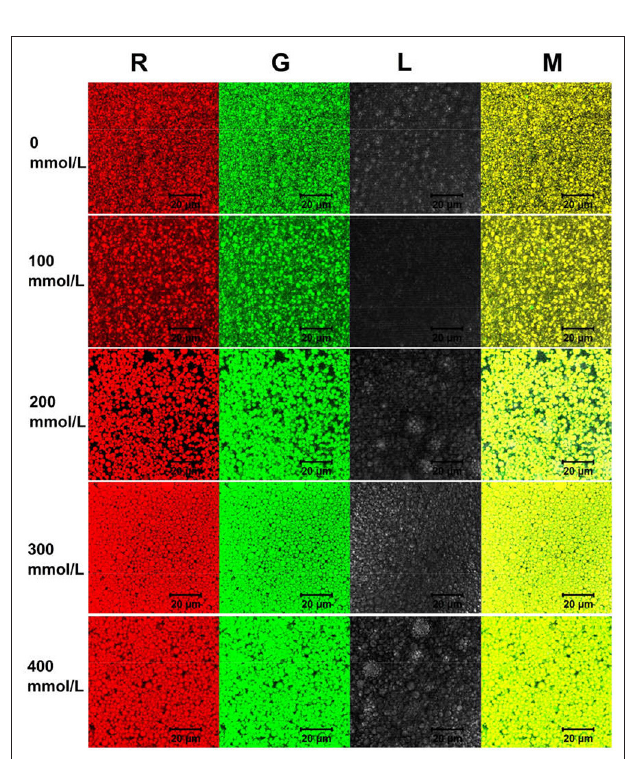
FIGURE 7 | Confocal laser scanning microscopy images of Pickering emulsions by tea water-insoluble protein nanoparticles under different ionic